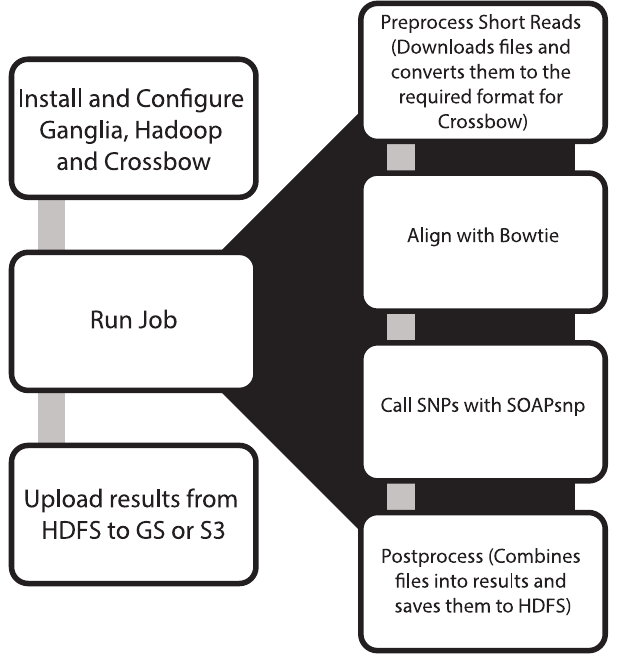
Figure 3. Analytical pipeline demarcating each step required to complete the Crossbow job in the cloud.